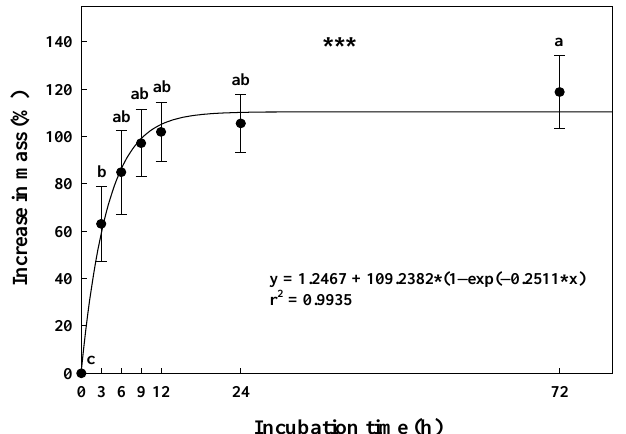
Figure 1. Changes in the mass of the Gentiana triflora var. japonica (Kusn.) H. Hara seeds during water incubation. The seeds were incubated at room temperature (approximately 25 ± 2 °C) on filter paper moistened with distilled water for 24 h. Vertical bars represent the standard deviation from the mean ( n = 4). Different letters in the same column indicate significant differences based on Tukey’s multiple range test ( p ≤ 0.05). *** Significant at p ≤ 0.001.